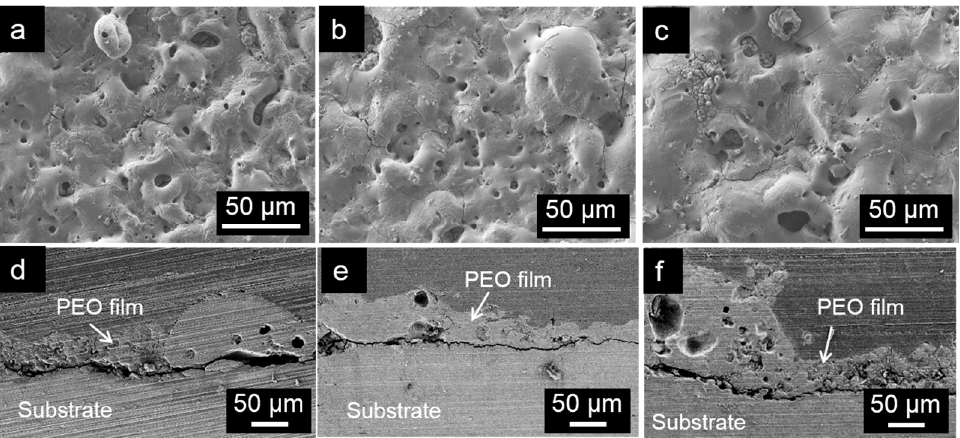
Figure 5. The film structure resulting from 20 min anodization in 0.5 mol·dm − 3 Na 3 PO 4 solution at 25 °C in plane and cross-sectional views on ( a , d ) AM60; ( b , e ) AM60-1Ca; and ( c , f ) AM60-2Ca.